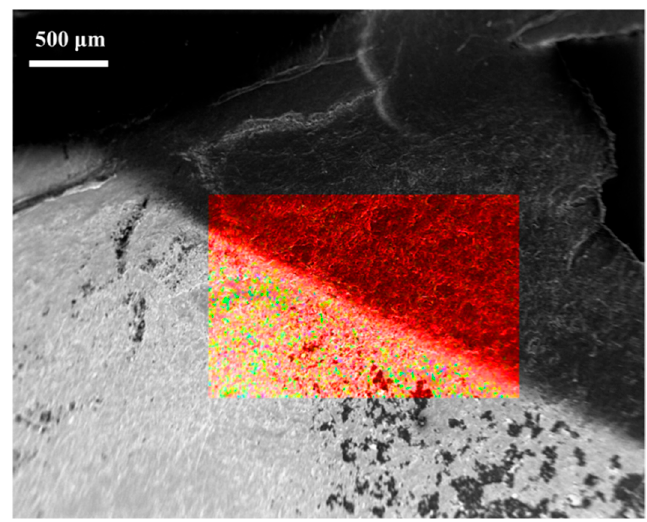
Figure 5. EDX color mapping image and EDX spectra of the border area between a WO 3 / BP membrane (lower area) and a BP membrane (upper area).